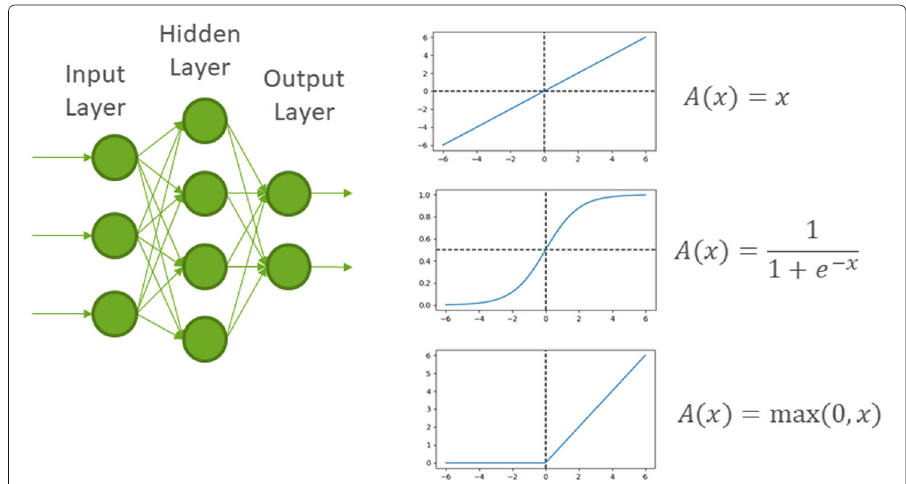
Fig. 1 Fully connected ANN with three input neurons, two output neurons, and one hidden layer (l.). Activation functions (r.) from top to bottom: identity, sigmoid and ReLU. In each of the neurons, a weighted sum is calculated and sent through an activation function as output to the next layer of neurons. The activation function defines how the output is forwarded (Schmidhuber 2015). Backpropagation is used to adjust the weights of the network to the current output error (Rumelhart et al.